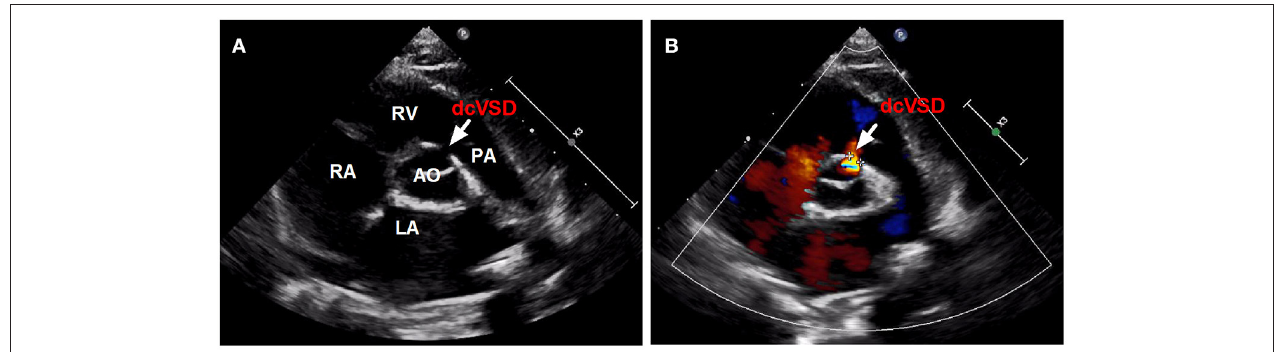
FIGURE 1 | The confirmed diagnosis of dcVSD by TTE. Parasternal short-axis view (A,B) on TTE shows the dcVSD located at the 1-2 o’clock position (arrows). AO, aortic; LA, left atrium; RV, right ventricle; RA, right atrium; PA, pulmonary artery; dcVSD, doubly committed subarterial ventricular septal defect; TTE, transthoracic